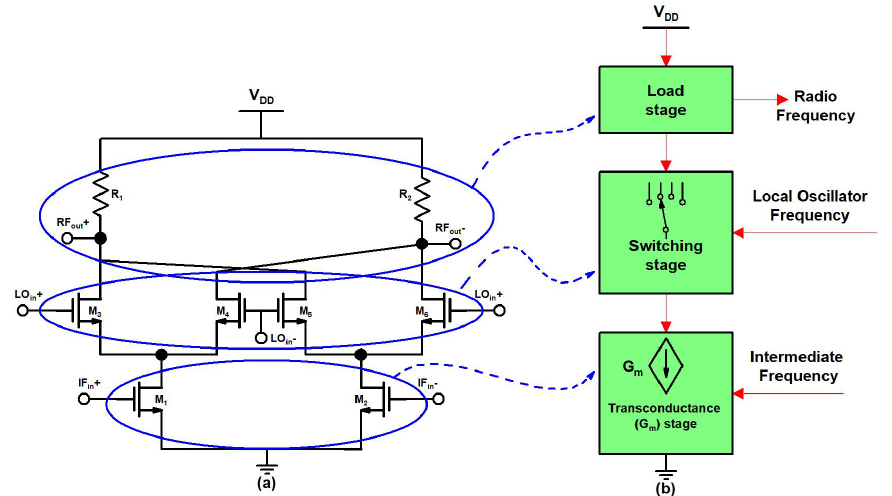
Figure 3. ( a ) Schematic and, ( b ) block diagram of traditional double-balanced Gilbert mixer.